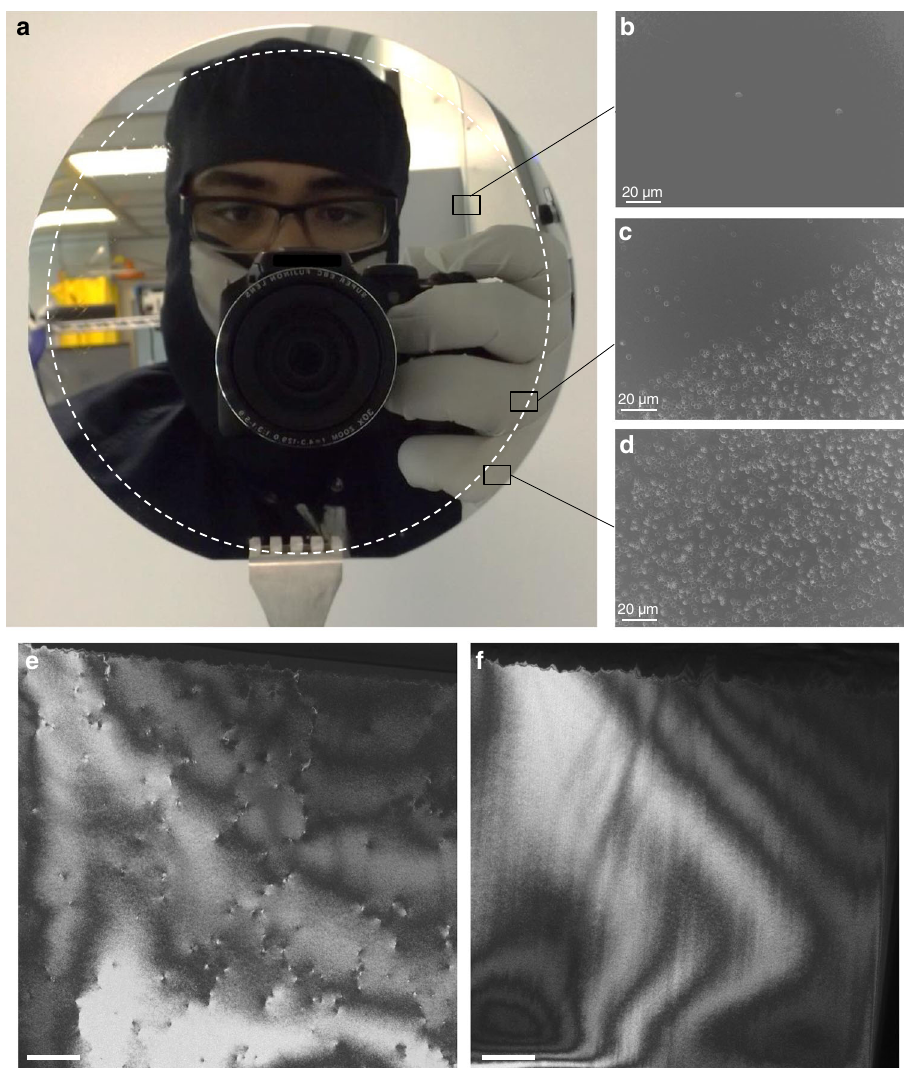
Fig. 6 Evaluation of threading dislocation densities. a Picture of the nanovoid-based Ge/Si virtual substrate (NVS) produced on a 4 in. wafer. Etch-pits densities taken from different regions of the NVS providing a lower limit for the TD density of ~10 4 cm − 2 for 1.5 µ m-thick Ge layer ( b ), from the edge of the NVS with an untreated area ( c ) and from an untreated area with a TD density of ~10 7 cm − 2 ( d ). Plan-view TEM micrographs marking the emergence sites of dislocations on Ge fi lms on Si taking from e untreated Ge/Si sample and f the NVS sample. Scale bars 500 nm. These observations con fi rm the